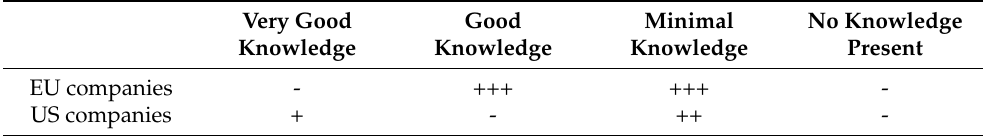
Table 5. Comparison of the degree of export knowledge in relation to the EU and US market;